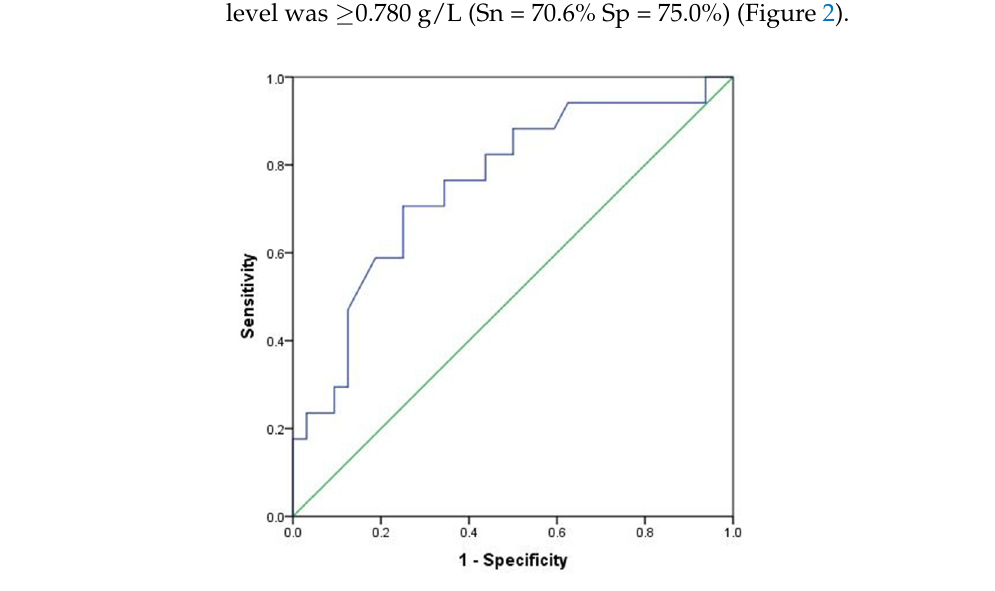
Figure 2. ROC curve analysis of C3 level in differentiating transition from active into latent EBV